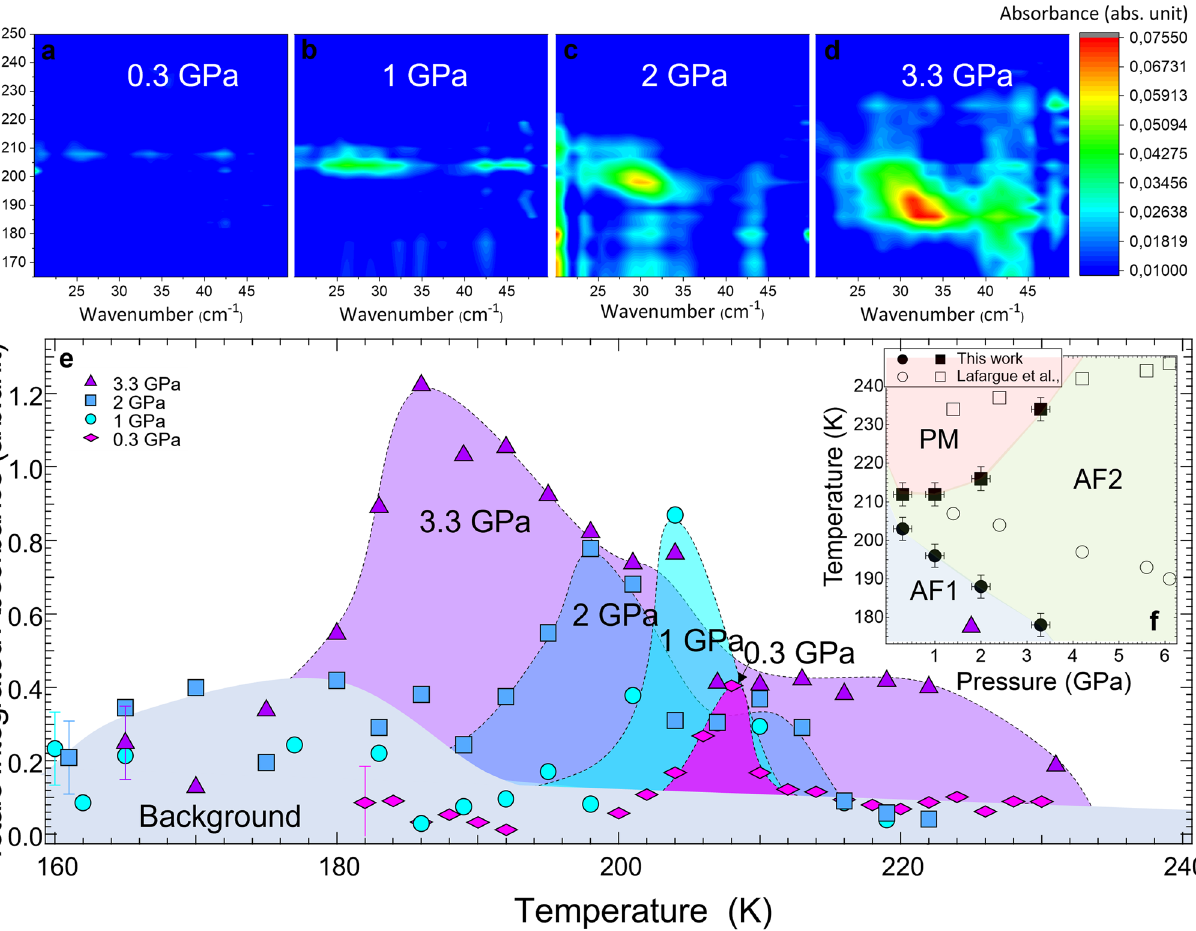
Fig. 3 Pressure dependence of the integrated electromagnon absorbance as a function of temperature. a – d 2D colormap of the integrated absorbance (color scale) as a function of wavenumber ( x ) and temperature ( y ). e Total integrated absorbance extracted between 20 and 50 cm − 1 (0.6 – 1.5 THz) as a function of temperature for each value of pressure. The background (see Methods) represented in gray is evaluated from the contribution of the other 2 excitations (EX1 and EX2). y error bars are represented for the low-temperature point for each value of pressure and are equal to ±0.1 (background value of the total integrated absorbance). f P-T phase diagram of CuO obtained from our THz spectroscopy determination of the temperature range of existence of the EM electromagnon compared to the previous dielectric constant measurements from Lafargue et al. 7 . The x and y error bars are estimated from the temperature and pressure experimental determination and are equal to ±0.2 GPa and ±3 K for x error bar and y error bar,